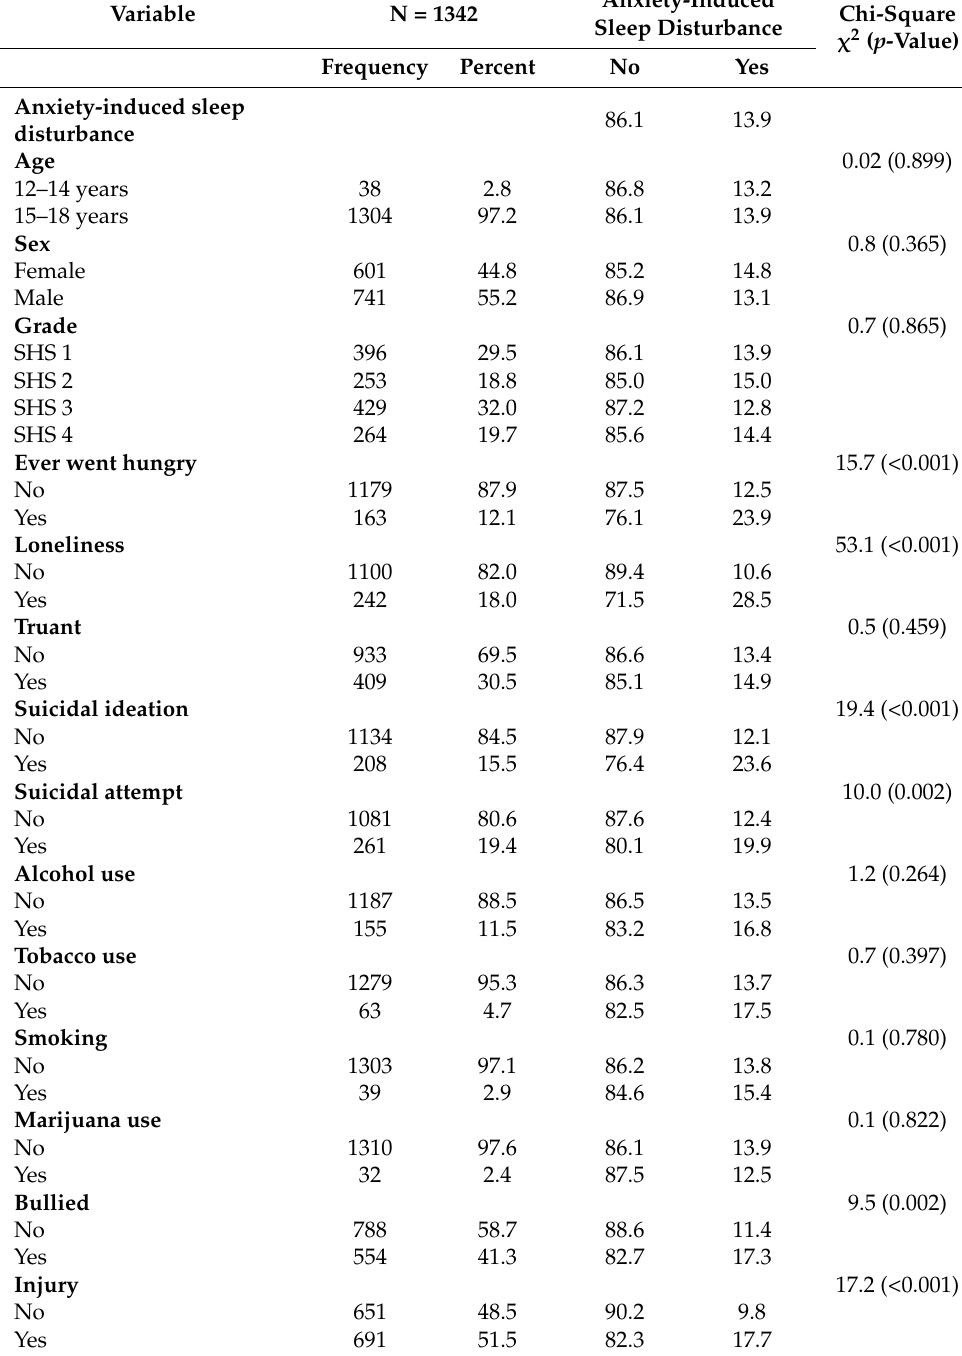
Table 1. Bivariate Analysis of the Proportion of Anxiety-induced sleep disturbance among In-school Adolescents in Ghana. Variable N = 1342